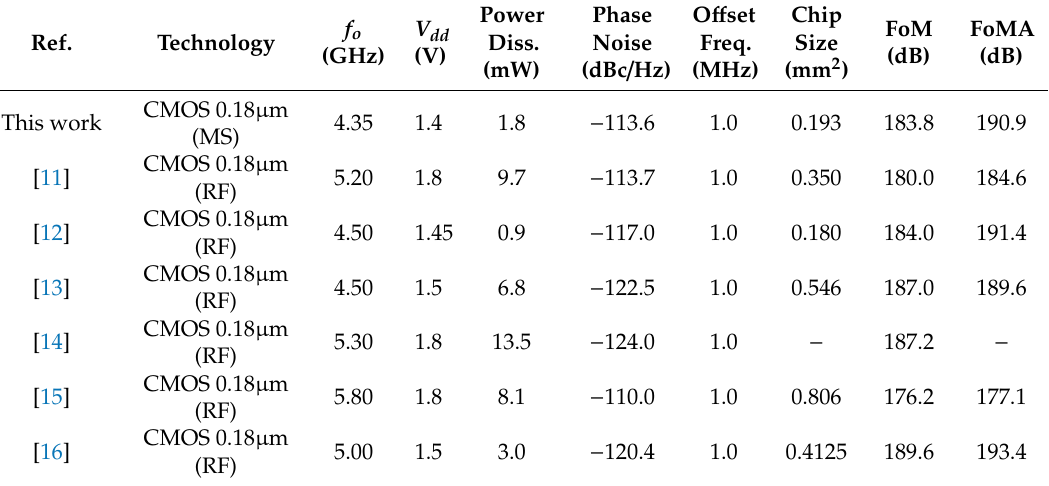
Table 1. Performance comparisons with reported